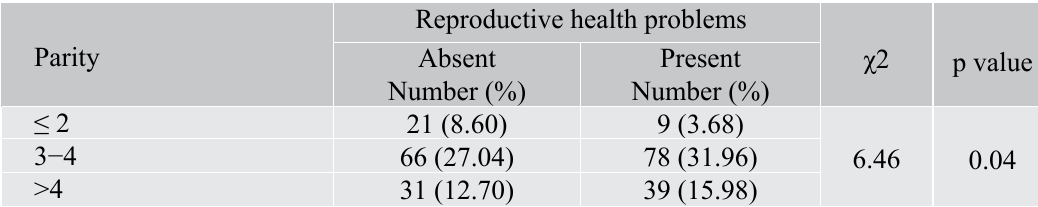
Table II: Association of number of pregnancy with reproductive health